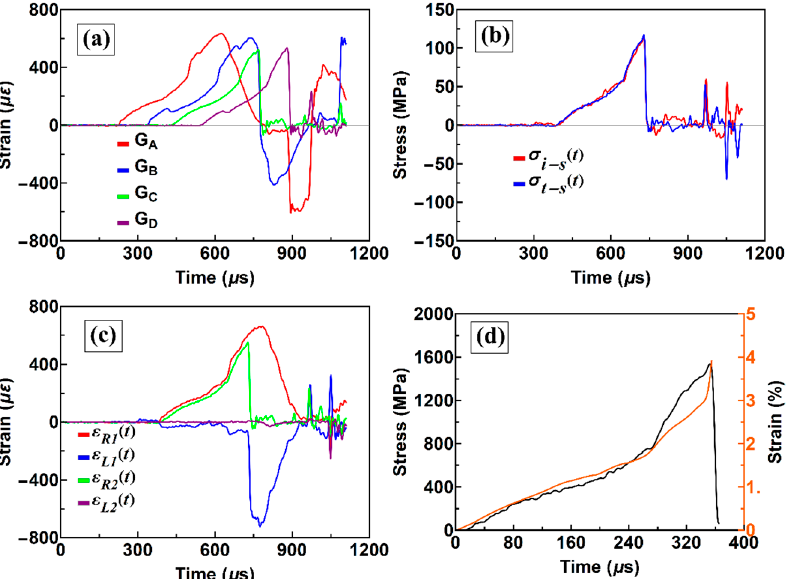
Figure 4. Typical signals of a modified SHPB: ( a ) original stress signals from four incident and transmission gauges; ( b ) interface stress between the bar and sample; ( c ) four right-going and left-going stress waves; and ( d ) the stress and strain history curves of the sample.